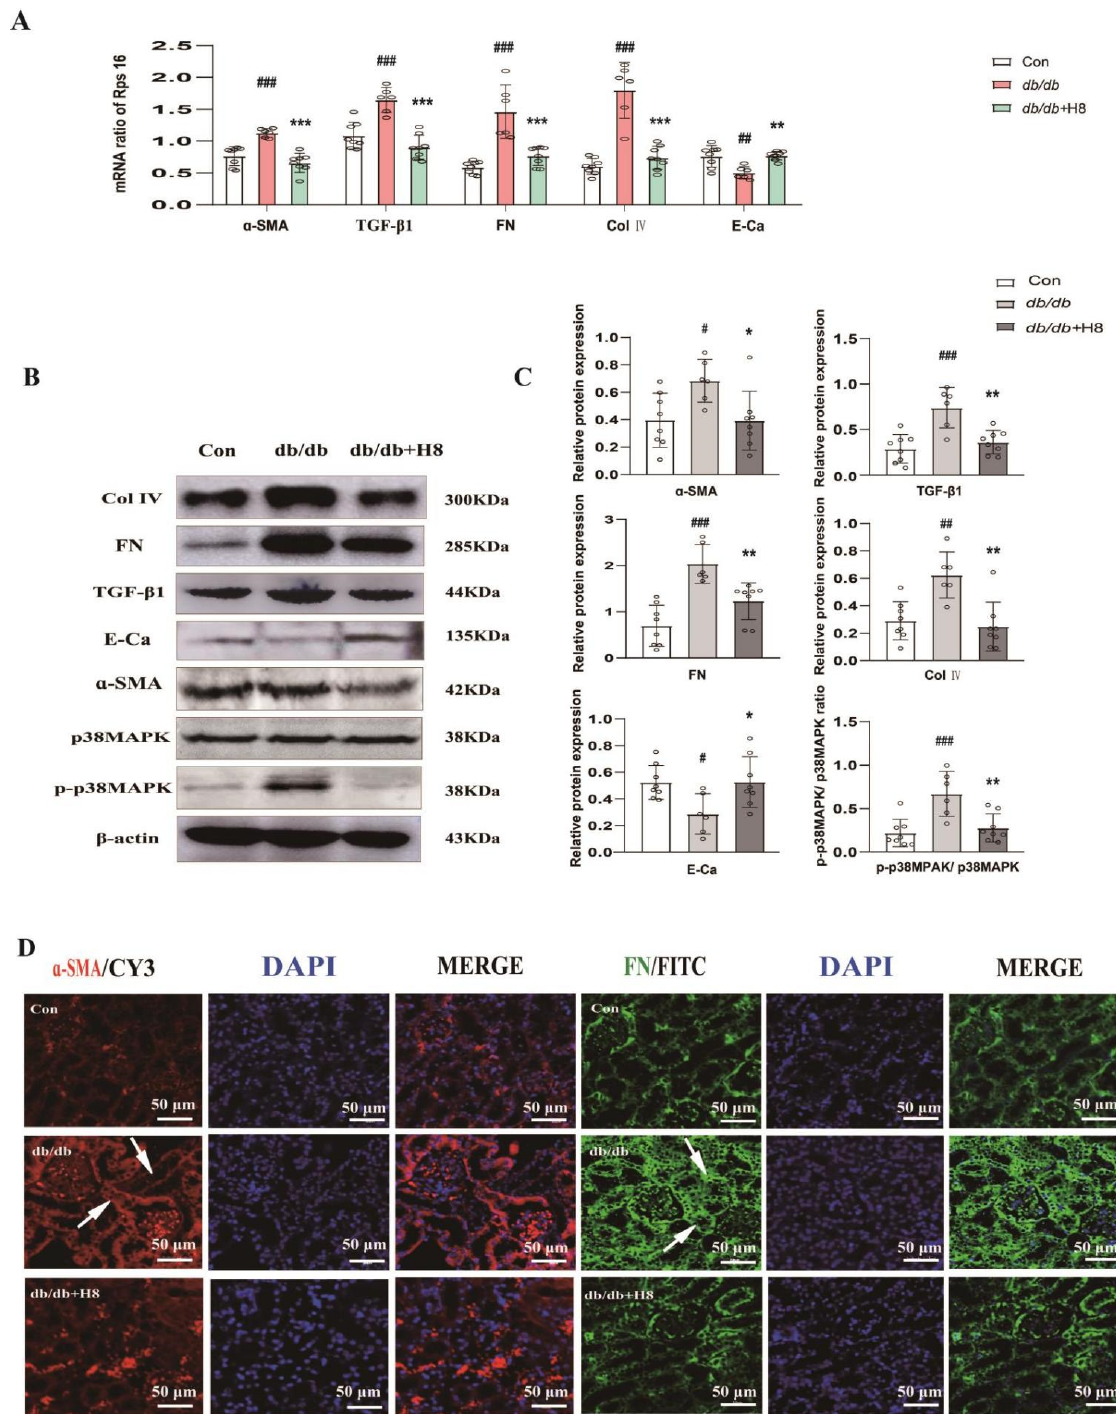
Figure 6. H8 reduced the fibrosis in renal tubule and inhibited p38MPAK signaling pathway in db/db mice. ( A ) The mRNA expression levels were examined by qPCR, and the values were normalized to rps16 ( α -SMA, TGF- β 1, FN, Col IV, and E-Ca). ( B ) Western blot band. ( C ) The protein relative expression levels ( α -SMA, TGF- β 1, FN, Col IV, E-Ca, and the ratio of P-p38MAPK/p38MAPK). ( D ) IF was performed using α -SMA and FN antibodies, and DAPI was used for staining cell nuclei (scale bar = 50 μ m); white arrows represent the protein expressions of α -SMA and FN in renal tubule. Data are shown as mean ± S.D. ( db/m n = 8, db/db n = 6, and db/db + H8 n = 8). # p < 0.05, ## p < 0.01, and ### p < 0.001 compared to Con group; * p < 0.05, ** p < 0.01, and *** p < 0.001 compared to db/db